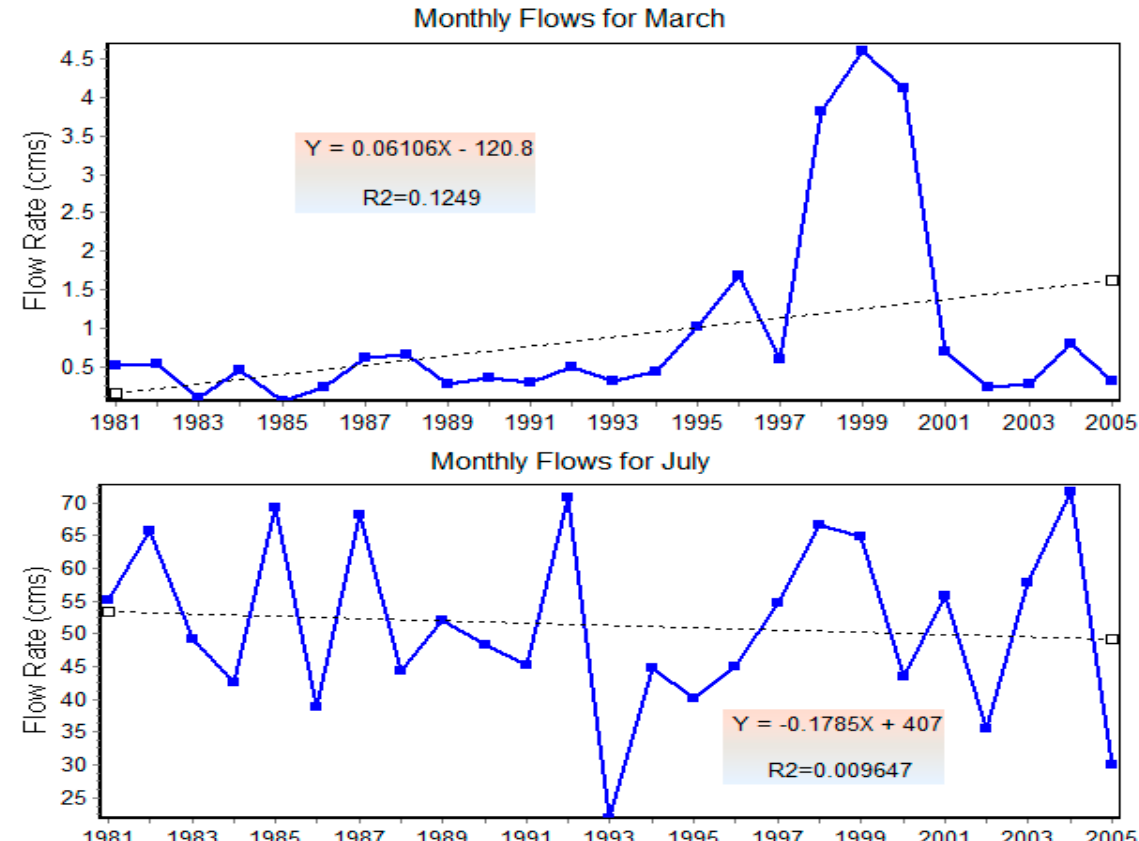
Figure 10. Monthly flow average in m 3 s − 1 of Ribb River since 1981 to 2005.